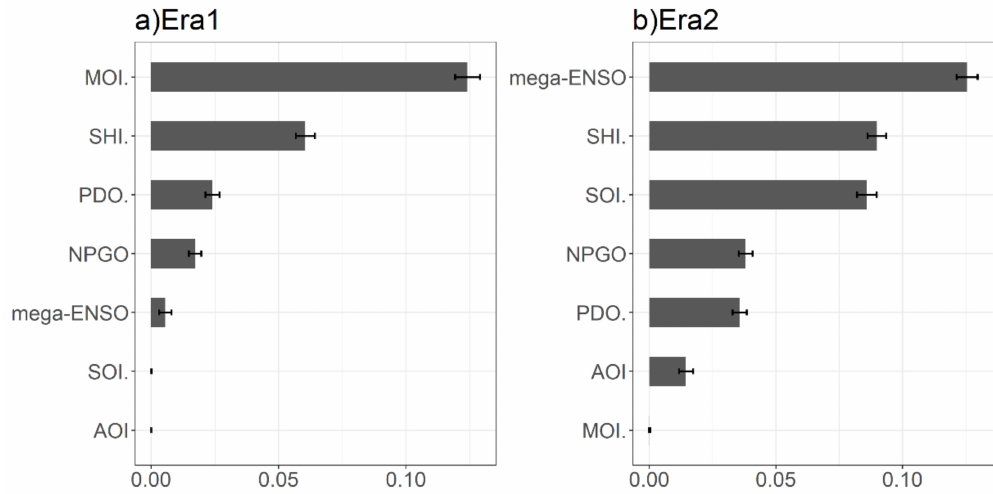
Figure 5. ( a , b ) The era-specific R 2 weighted importance of climate drivers to winter SST with error bars, as obtained by the gradient forest analysis.